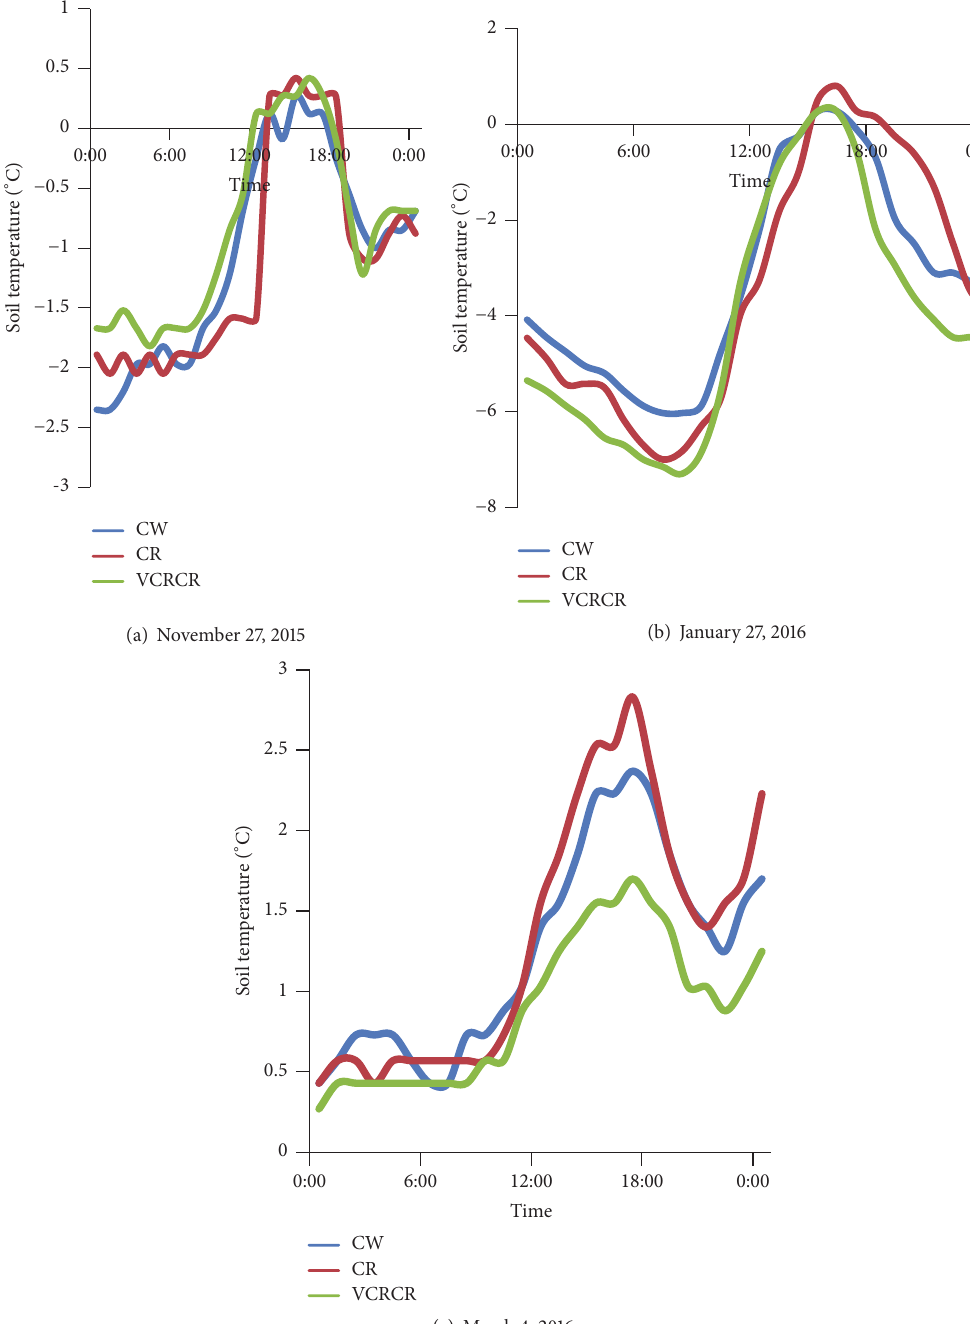
Figure 5: Temporal soil temperature changes on interrow soil surface under different postsowing compaction treatments. Table 1: Shoot number under different treatments on November 27, 2015, and March 4, 2016 (thousands/ha).